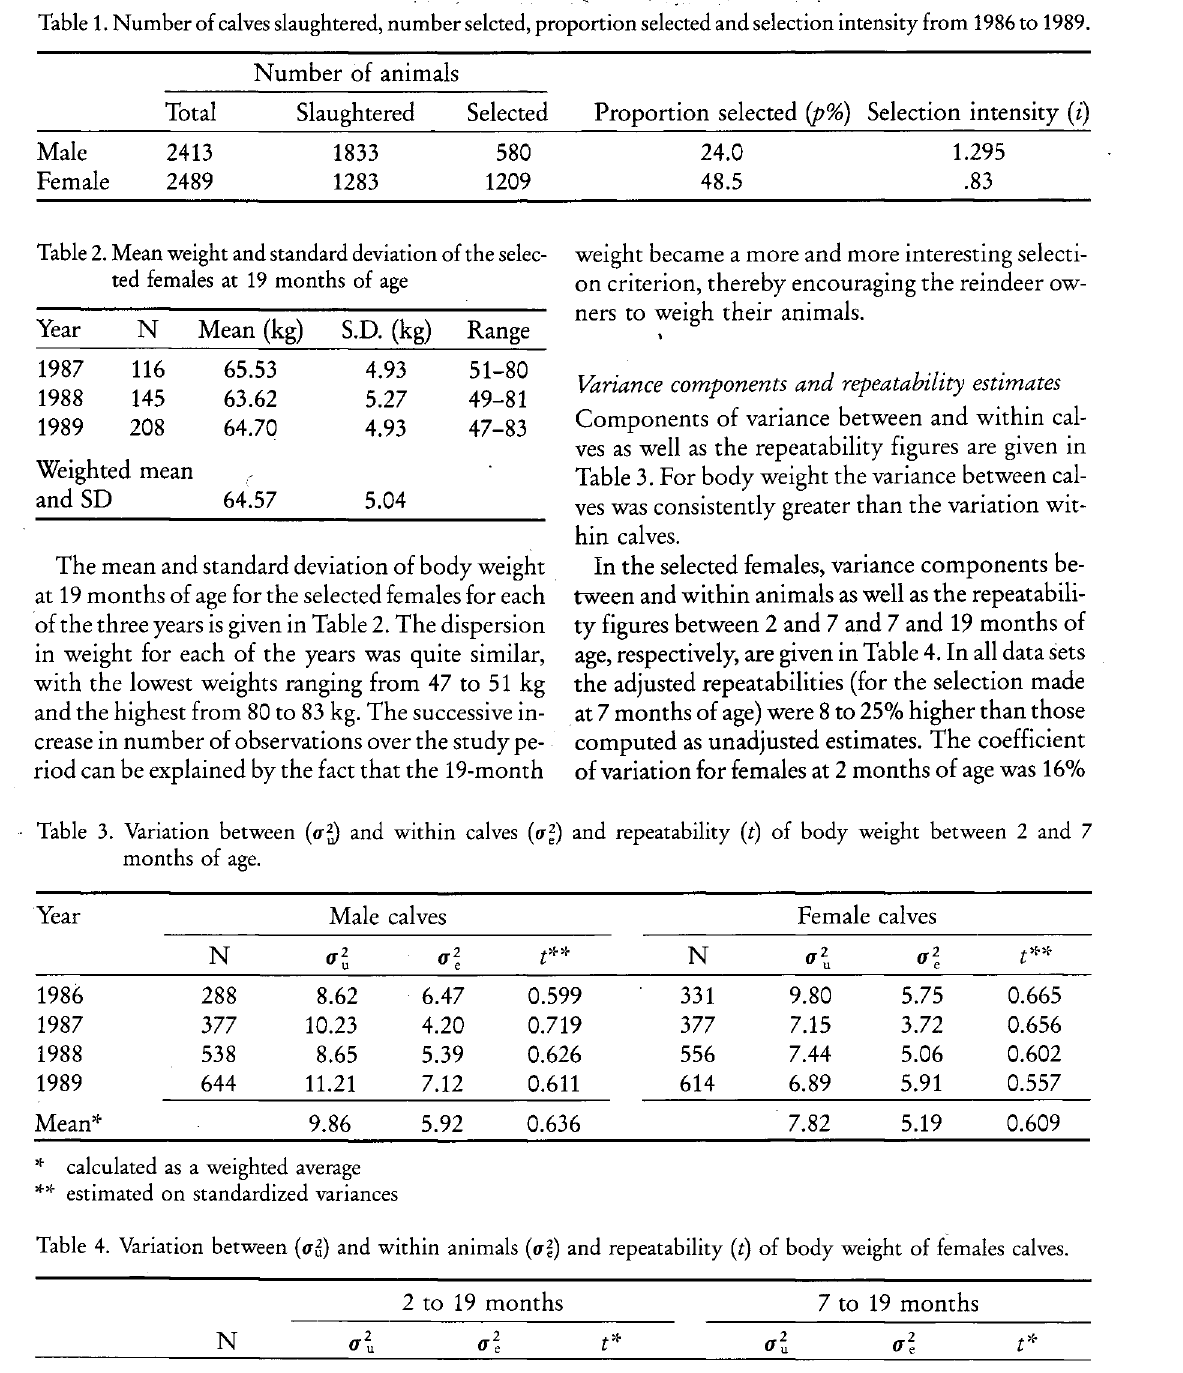
Table 1. Number of calves slaughtered, number selcted, proportion selected and selection intensity from 1986 to 1989.